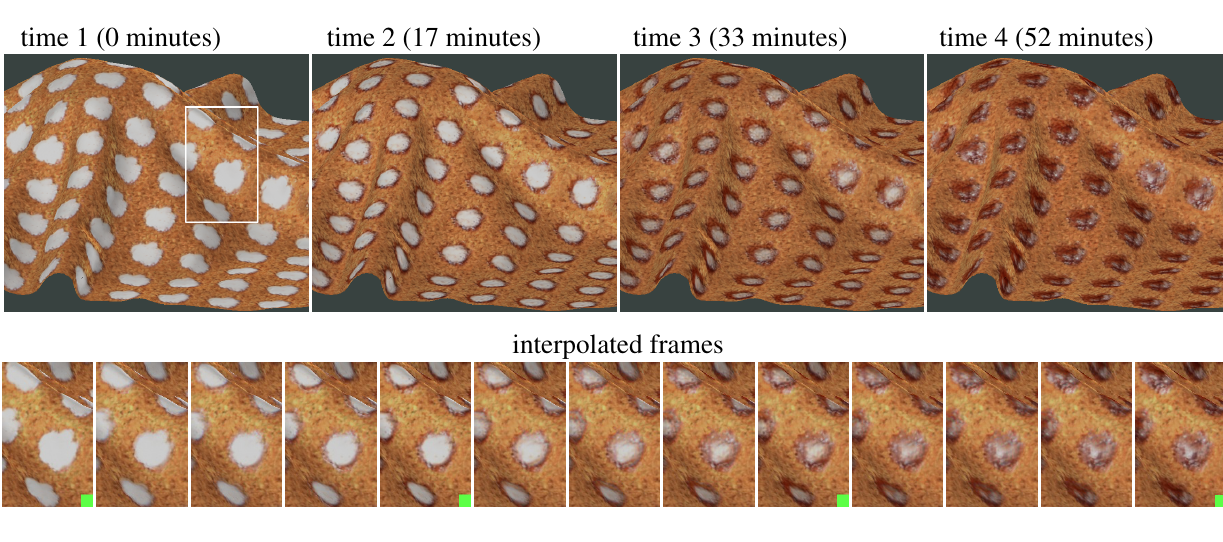
Figure 14. Interpolation of the time-frames 1 and 2 ( a ) ( ∆ t = 17 min, 71 × 70 pixels) using: ( b ) linear interpolation; ( c ) STAF algorithm; and ( d ) displacement interpolation (DI).